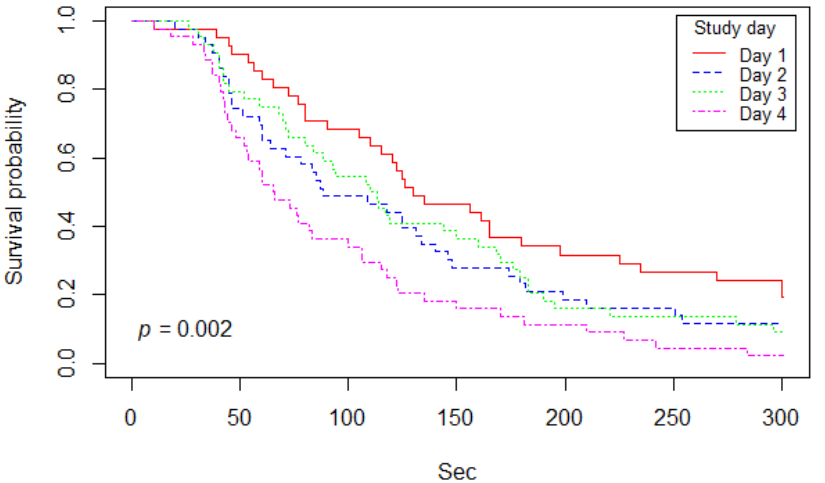
Figure 6. Kaplan–Meier curve of bait handling time separated based on study day (Day 1–28, day 2–29, day 3–30, and day 4–31 January 2020).